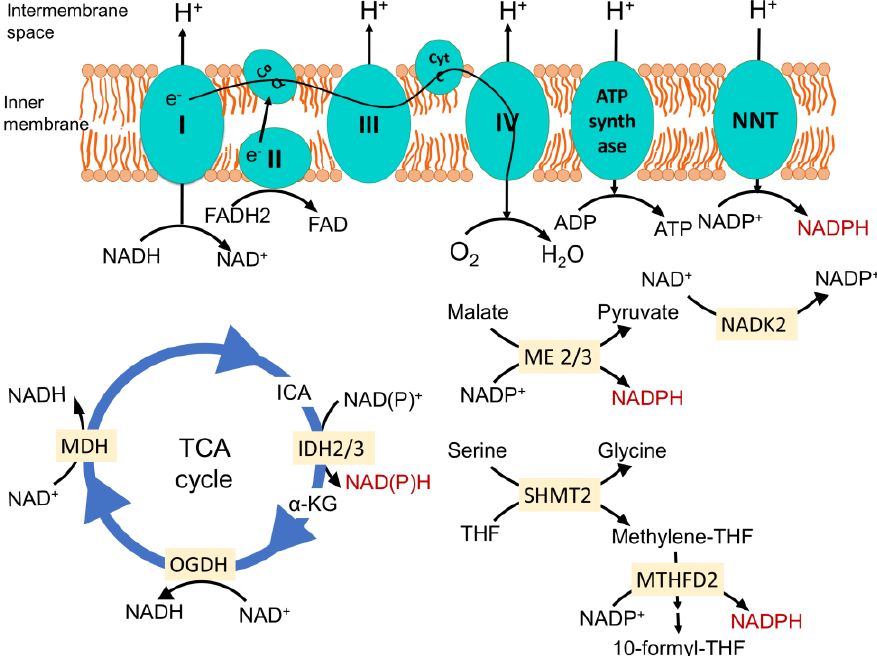
Figure 1. Mitochondrial major NADPH-producing pathways. Nicotinamide nucleotide transhydro- genase (NNT) located in the inner membrane produces NAPDH from NADP + . It is energized by the inner membrane electrochemical gradient, produced by proton translocation via the electron transport chain (ETC) during the sequential flow of electrons from reducing equivalent NADH and FADH 2 to O 2 to form H 2 O. This enzyme plays a pivotal role in dedicating the mitochondrial NADH pool towards maintenance of the optimum NADPH level. Isocitrate dehydrogenase 2 (IDH2) in the TCA cycle catalyzes the oxidative decarb oxylation of isocitrate to α -ketoglutarate, and malic en- zymes 2 and 3 (ME2 and ME3) catalyze the oxidative decarboxylation of malate to pyruvate while generating NADPH from NADP + in the process. In the one carbon metabolism once serine is catab- olized by serine hydroxymethyl transferase 2 (SHMT2), it generates methylene-THF. The NAD ki- nase (NADK2) phosphorylates NAD + to NADP + , feeding other NADPH-generating reactions. Meth- ylene tetrahydrofolate dehydrogenase 2 oxidizes it to methenyl tetrahydrofolate and, finally, to 10- formyl-THF, which is coupled to the reduction of NADP + to NADPH. CoQ, coenzyme Q; Cyt C, cytochrome C; ICA, isoci trate; α - KG, α -ketoglutarate; OGDH, oxoglutarate dehydrogenase; MDH, malate dehydrogenase; THF, tetrahydrofolate; I, II, III and IV represents complexes I, II, III and IV in the mitochondrial electron transport chain. ROS can also be produced in a regulated manner for signaling via NADPH oxidases (NOX proteins), which generates a superoxide from O 2 while oxidizing NADPH. Among seven catalytic isoforms, NOX1, NOX2, NOX4 and NOX5 are associated with cancer de- velopment, having different subcellular locations. NOX-derived ROS signaling induces proliferation upon growth factor stimulation and promotes angiogenesis, cell migration and invasion [17]. NOX4 localized in the inner mitochondrial membrane can produce ROS, which can directly oxidize mitochondrial complex subunits, as well as mediate mi- tochondrial DNA damage [18]. It also acts as an ATP sensor and mediates metabolic re- programming via regulating pyruvate kinase-M2 (PKM2) stability [19]. Mitochondrial superoxide is dismutated to H 2 O 2 by manganese superoxide dis- mutase (MnSOD/SOD2) in the matrix and by Cu/Zn superoxide dismutase (Cu/ZnSOD/SOD1) in the intermembrane space and cytosol. H 2 O 2 acts as diffusible sig- naling molecule and is neutralized for water by enzymes, including peroxiredoxin-thiore- doxin and glutathione peroxidases (GPX) [20]. Recent studies have drawn attention to- wards the pathological significance of mitochondrial peroxiredoxins, as their expression is associated with the initiation and progression of multiple types of cancers [21]. These